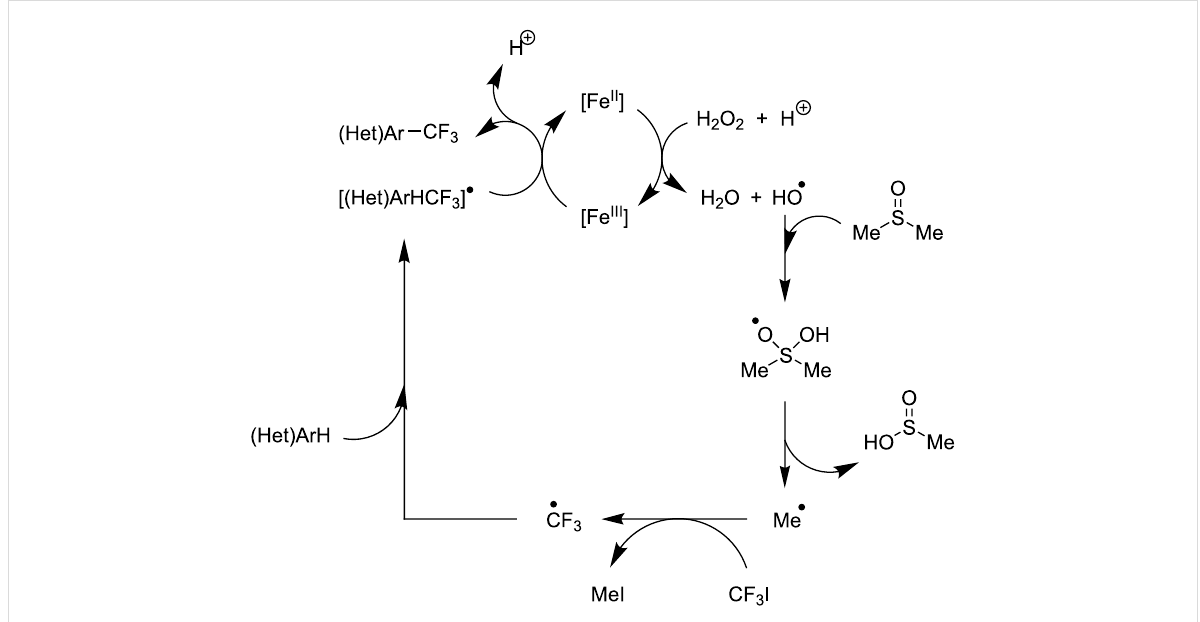
Figure 20: Mechanistic proposal by T. Yamakawa et al. for the Fe(II)-catalyzed trifluoromethylation of arenes and heteroarenes with trifluoromethyl iodide [114].